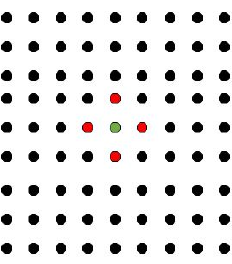
Figure 6. The peridynamic horizon of the single-particle spacing.